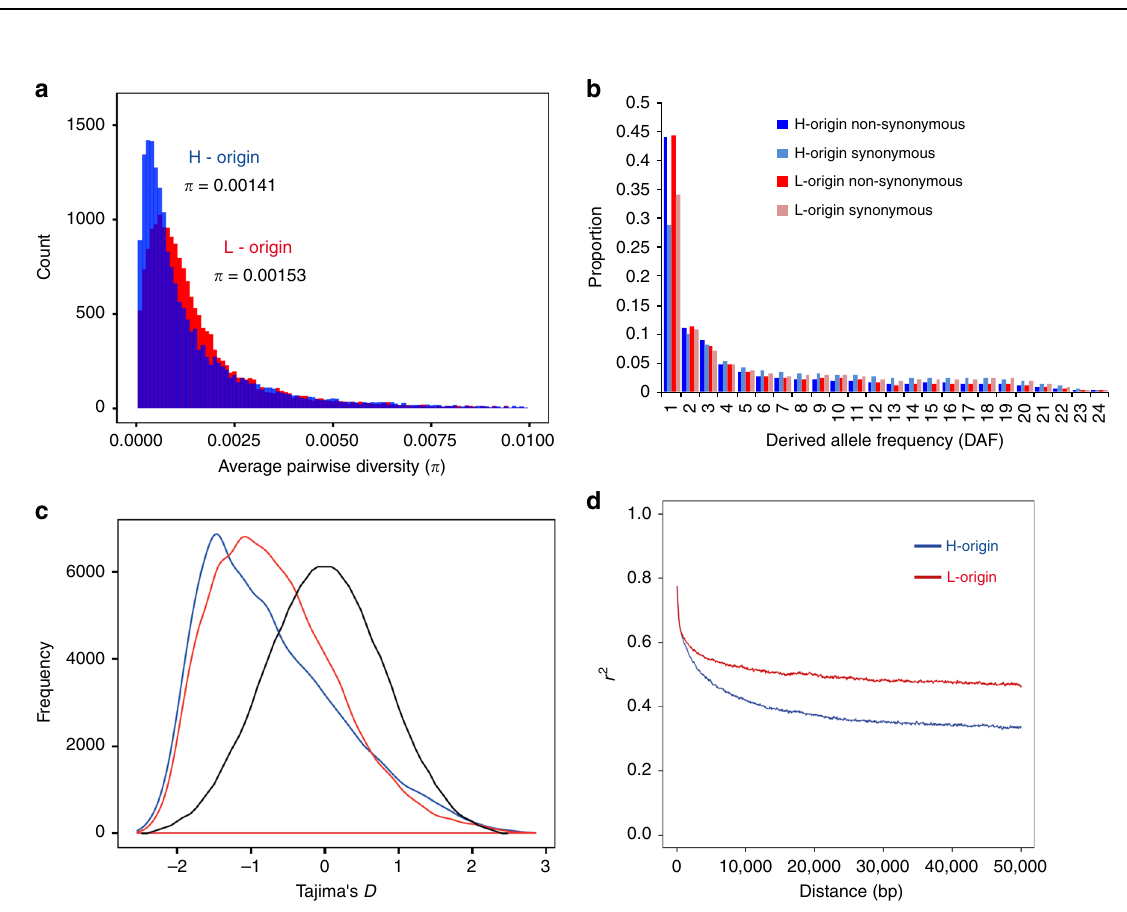
Fig. 1 Genome-wide diversity and linkage disequilibrium. a Nucleotide diversity (average pairwise diversity, π ) of halleri -origin (H-origin) and lyrata- origin (L-origin) coding sequences. b H-origin and L-origin genes show no signi fi cant differences in proportions of non-synonymous and synonymous substitutions ( χ 2 -test, p -value = 0.58), and the majority of substitutions are at low frequency. c Tajima ’ s D distributions for both genomes (blue density curve = H-origin, red density curve = L-origin) show departures from neutrality (black density curve where neutral = 0); mean values for both distributions are negative (Table 1). d The mean decay of linkage disequilibrium (LD) estimated using 50 kb sliding windows shows mean LD decay <20 kb for both H-origin (blue) and L-origin (red)